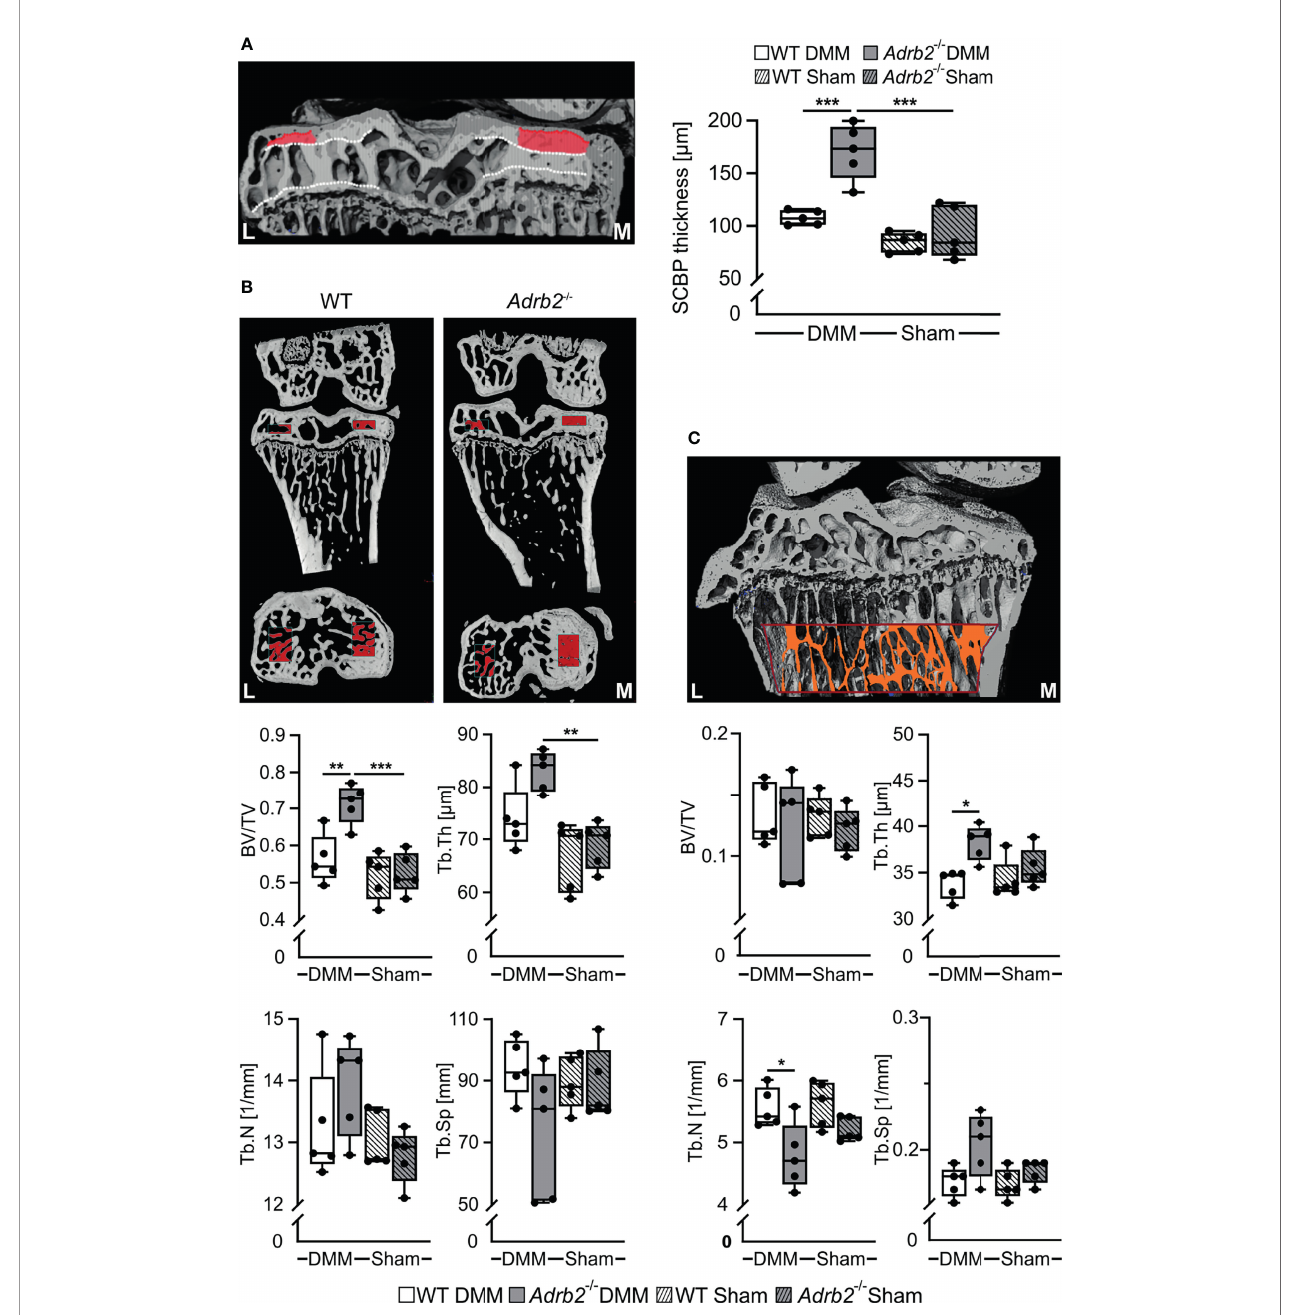
FIGURE 4 | Analysis of the subhcondral bone and subarticular trabecular bone. (A) Representative image of subchondral bone plate (SCBP) with the VOI and quanti fi cation of the SCBP thickness in WT and Adrb2 -/- mice 8 weeks after DMM or Sham surgery. (B) Representative micro-Ct images displaying the volume of interest (VOI, indicated by red rectangles) in the medial epiphysis and quantitative 3D analysis of bone volume to total tissue volume (BV/TV), trabecular spacing (Tb.Sp), trabecular number (Tb.N), and trabecular thickness (Tb.Th) within the VOI in WT and Adrb2 -/- mice 8 weeks after DMM or Sham surgery. (C) Representative micro-Ct image displaying the volume of interest (VOI, indicated by red-orange rectangle) in the subarticular trabecular bone and quantitative 3D analysis of bone volume to total tissue volume (BV/TV), trabecular spacing (Tb.Sp), trabecular number (Tb.N), and trabecular thickness (Tb.Th) within the VOI in WT and Adrb2 -/- mice 8 weeks after DMM or Sham surgery. Data are presented as box plots with whiskers. Each black circle represents an individual mouse (n=5 per group). Signi fi cant p-values between the treatment groups are presented as *p ≤ 0.05 and **p ≤ 0.01 and ***p ≤